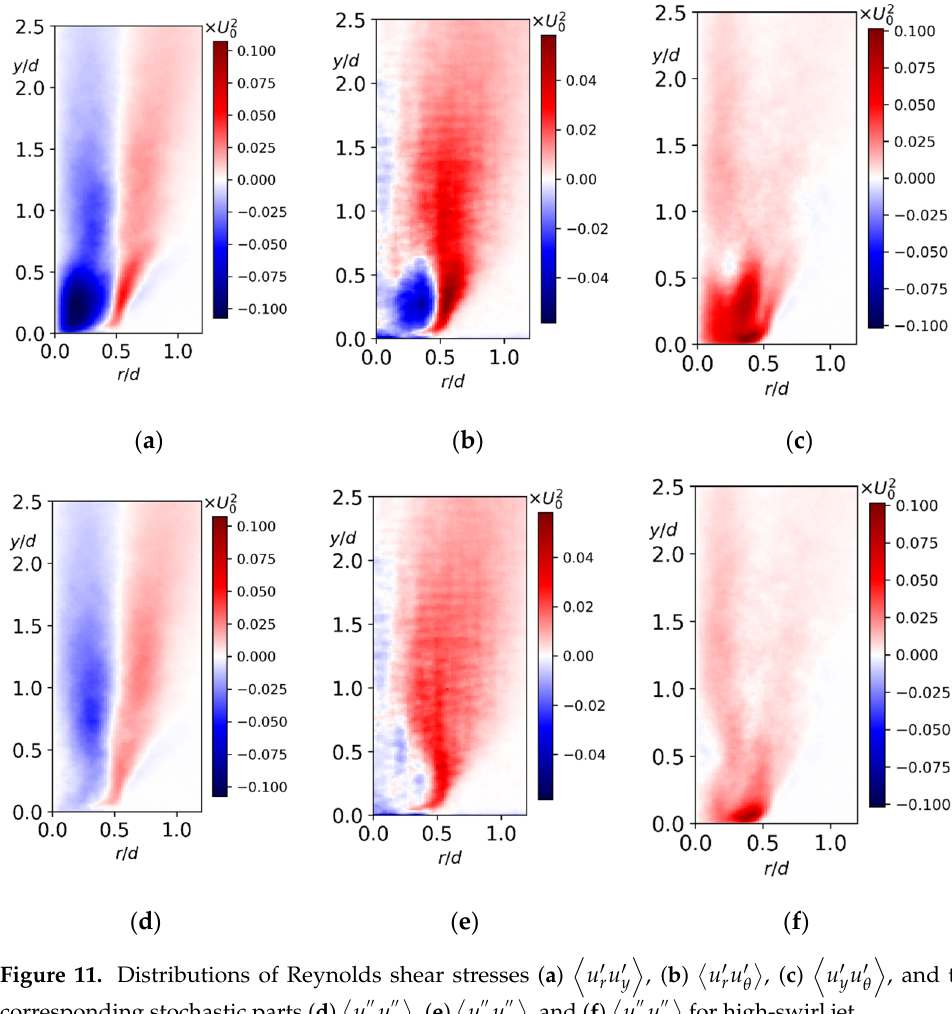
Figure 11. Distributions of Reynolds shear stresses ( a ) corresponding stochastic parts ( d )